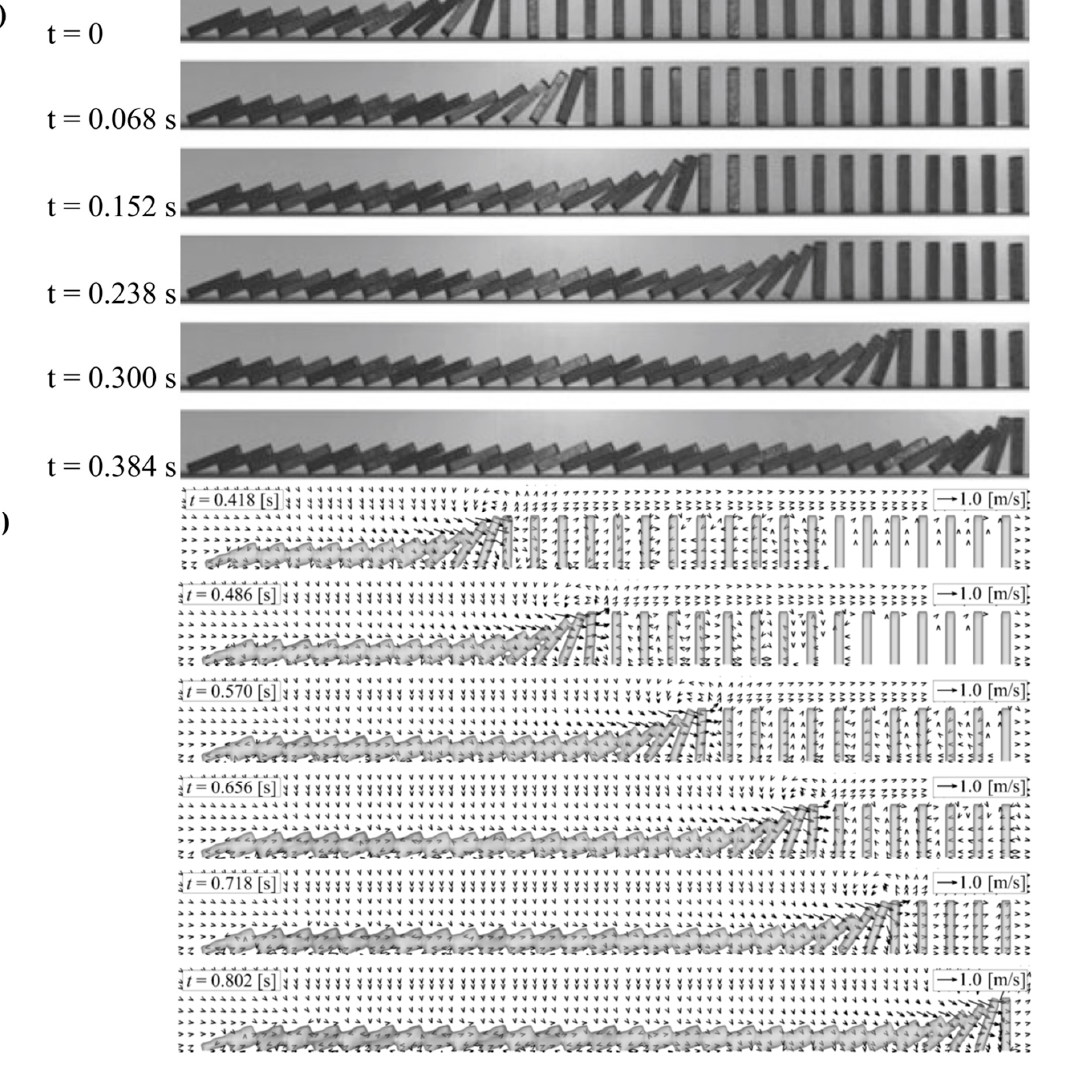
Figure 3. Comparison of the toppling dominos: ( a ) experimental results [26]; ( b ) numerical results.